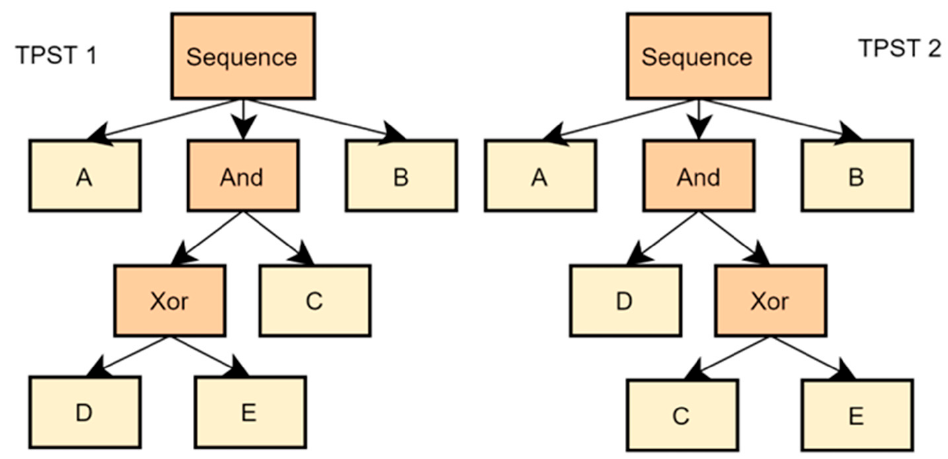
Figure 4. TPST structure corresponding to the business process in Figure 1.